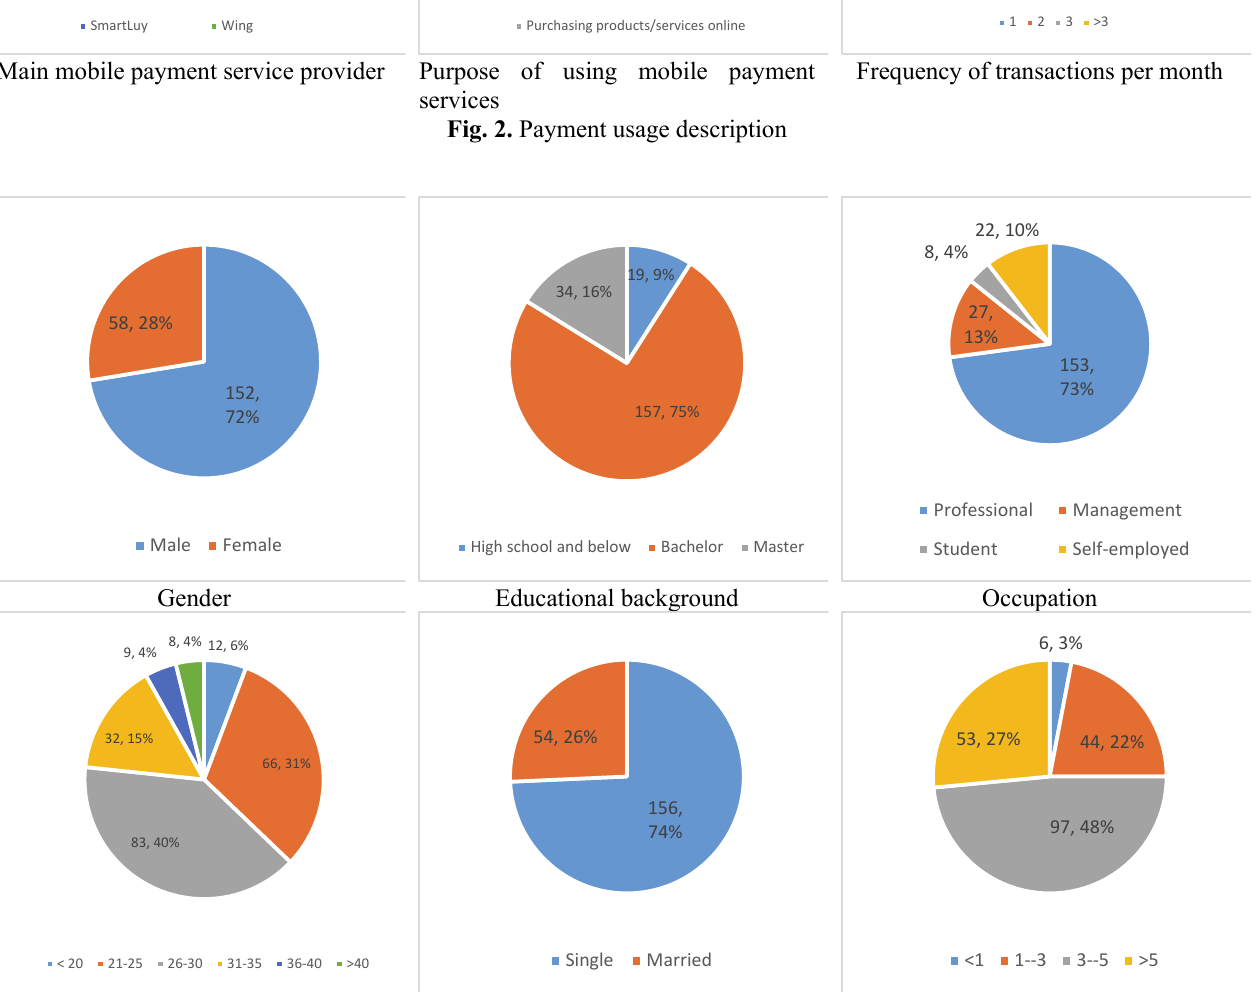
Fig. 3. Personal characteristics of the